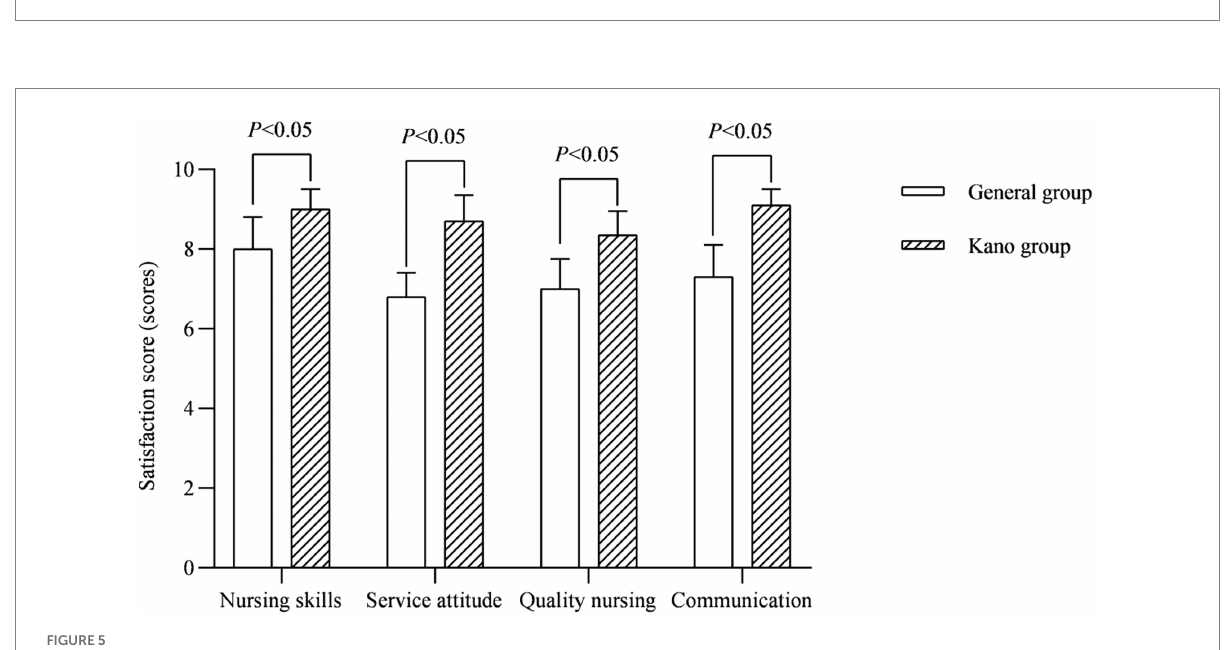
FIGURE 4 SCL-90 total score (scores).